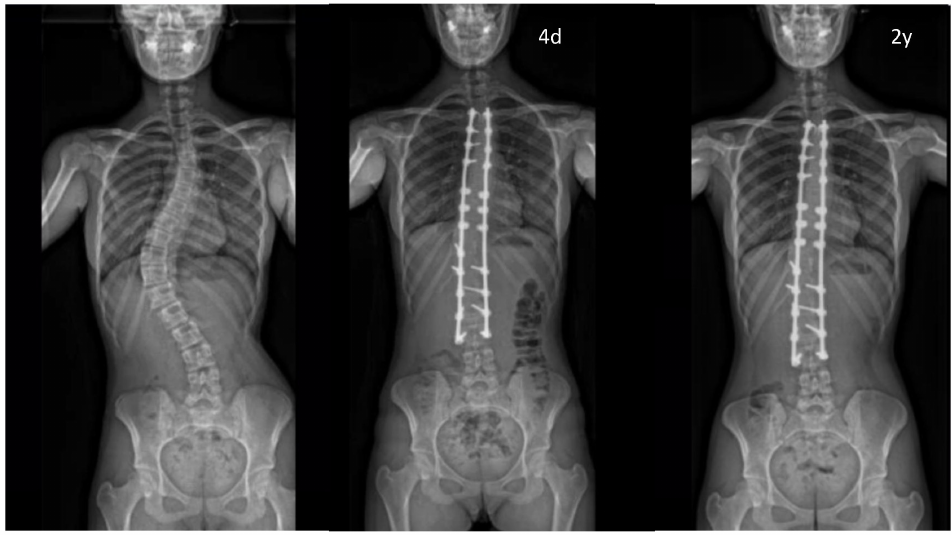
Figure 4. Pre- and post-operative full-spine coronal X-rays (1st erect and 2y po) illustrating the proper stabilisation of the main curve (<10 ◦ ) without any screw loosening. (4d: Day 4 after